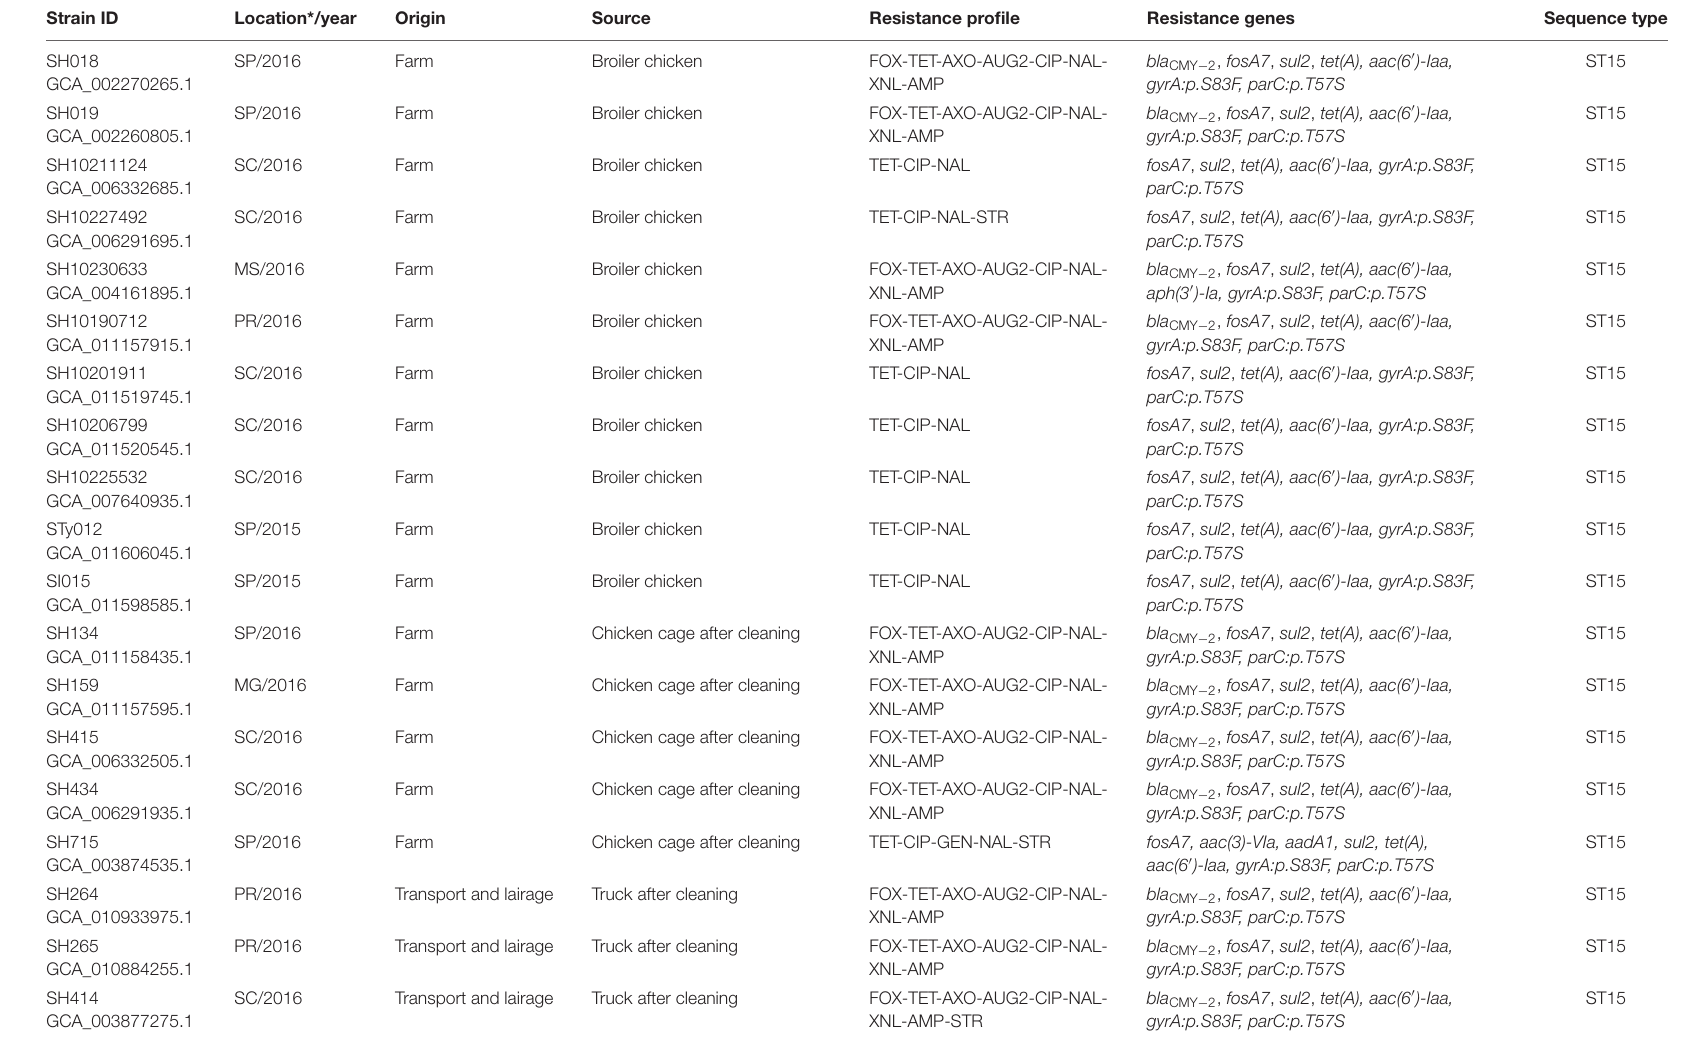
TABLE 1 | Features of S . Heidelberg strains ( n = 81) isolated from different